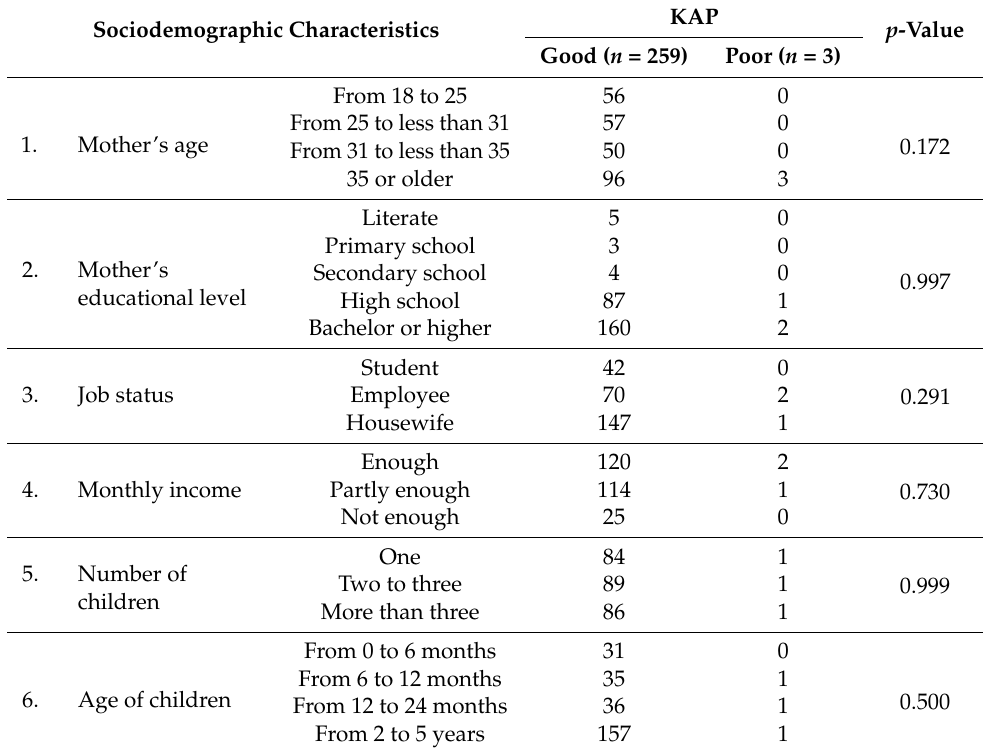
Table 5. Association between KAP and the demographics of the participating mothers ( N =